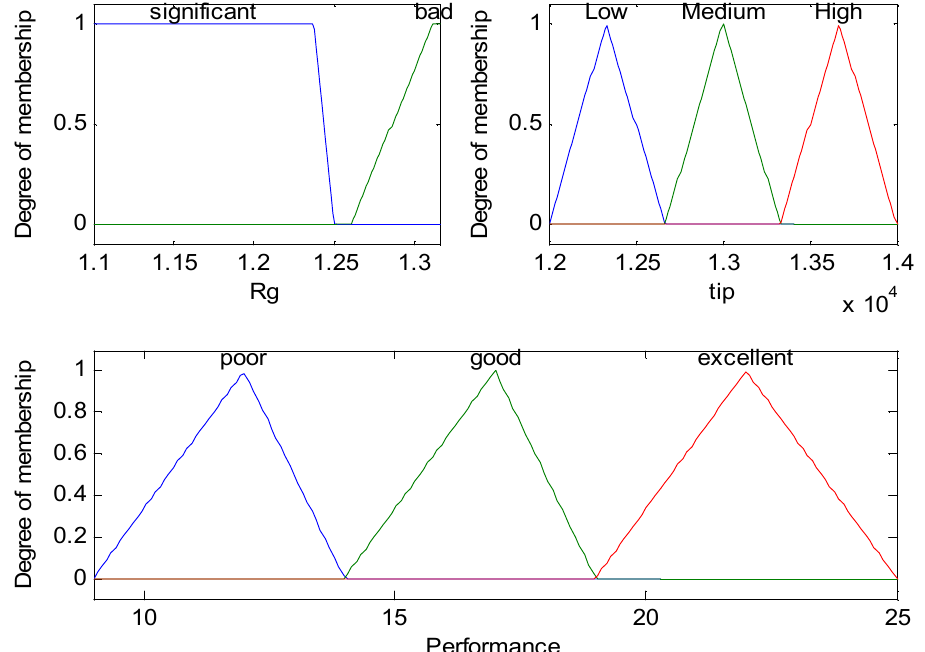
Figure 6. Membership functions of inputs R g (ground resistance) and tip (project cost) and the output performance.